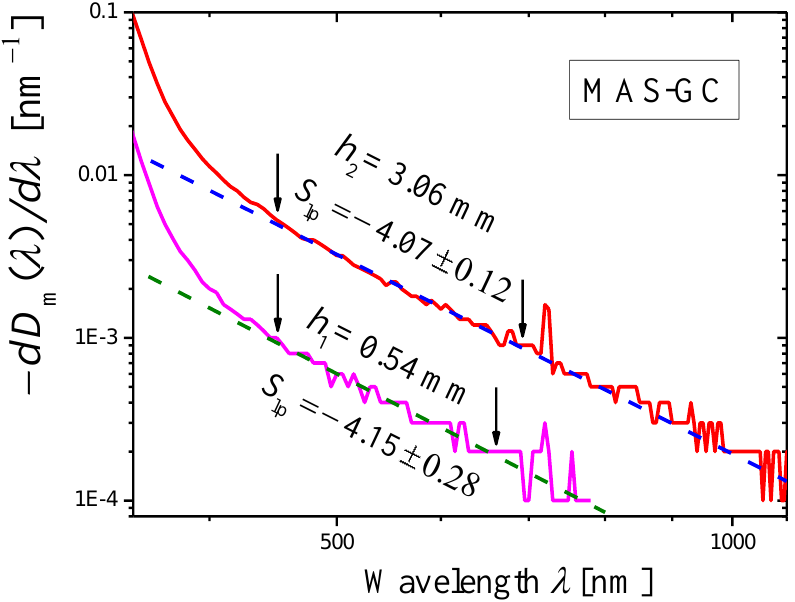
Figure 5. Log–log plots of the dependences of ( − dD i m ( λ ) / d λ ) on λ (curves) constructed for the measured optical densities D i m ( λ )( i = 1,2 ) of two samples of the MAS glass-ceramic studied in the present work. The thicknesses of the samples are: h 1 = 0.54 mm (magenta curve) and h 2 = 3.06 mm (red curve). The portion of each curve limited by arrows is approximated by a straight dashed line using the least squares method, and the slope S lp of the straight line is indicated in the figure.